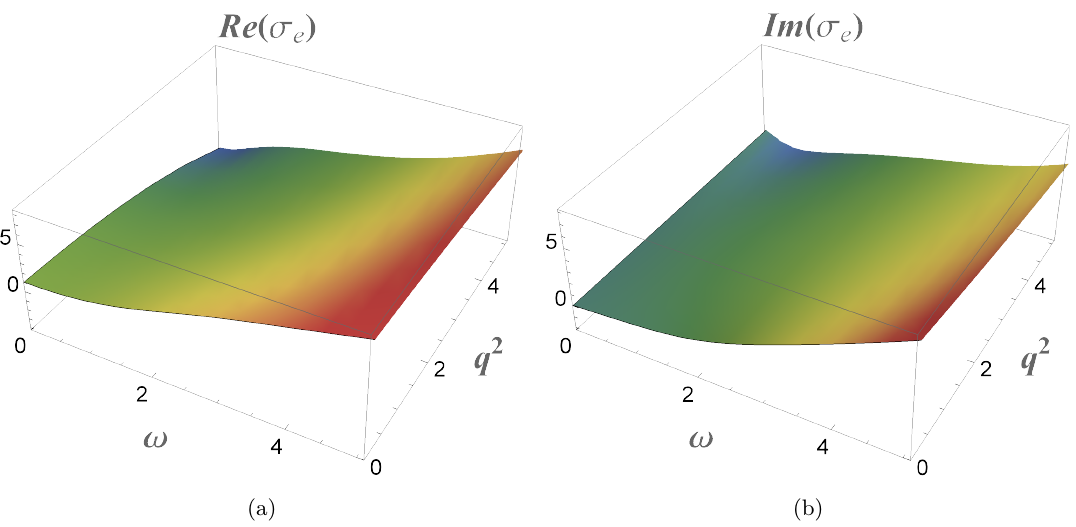
Figure 3 . Ther ω -, q -dependence of (a) Re ( σ e ( ω, q 2 )) , (b) Im ( σ e ( ω, q 2 ))